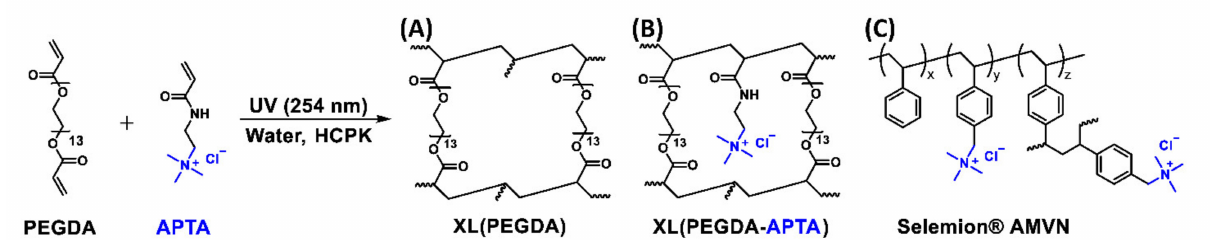
Figure 2. ( A , B ) Synthetic scheme of ( A ) crosslinked PEGDA, A0, and ( B ) crosslinked PEGDA-APTA, A8 and A12. ( C ) Schematic of Selemion AMVN, functionalized polystyrene-divinylbenzene (PS-DVB)-based